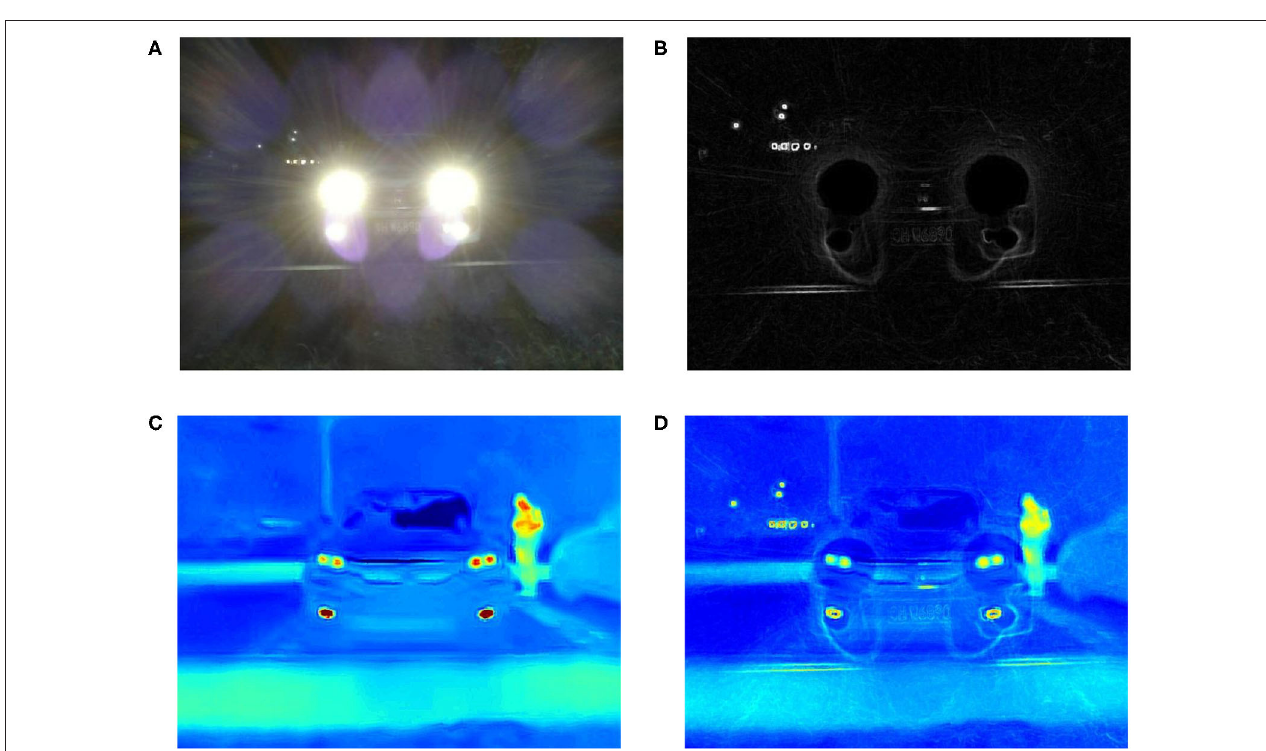
FIGURE 13 | Vehicle headlight feature extraction and fusion. (A) The Red Green Blue (RGB) image extracted from the original thermal image. (B) The RGB image after Sobel operation. (C) The thermal image extracted from the original thermal image. (D) A feature map synthesized by a thermal image and an RGB map.